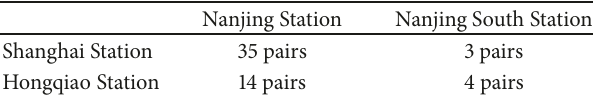
Table 2: Trips between different stations.